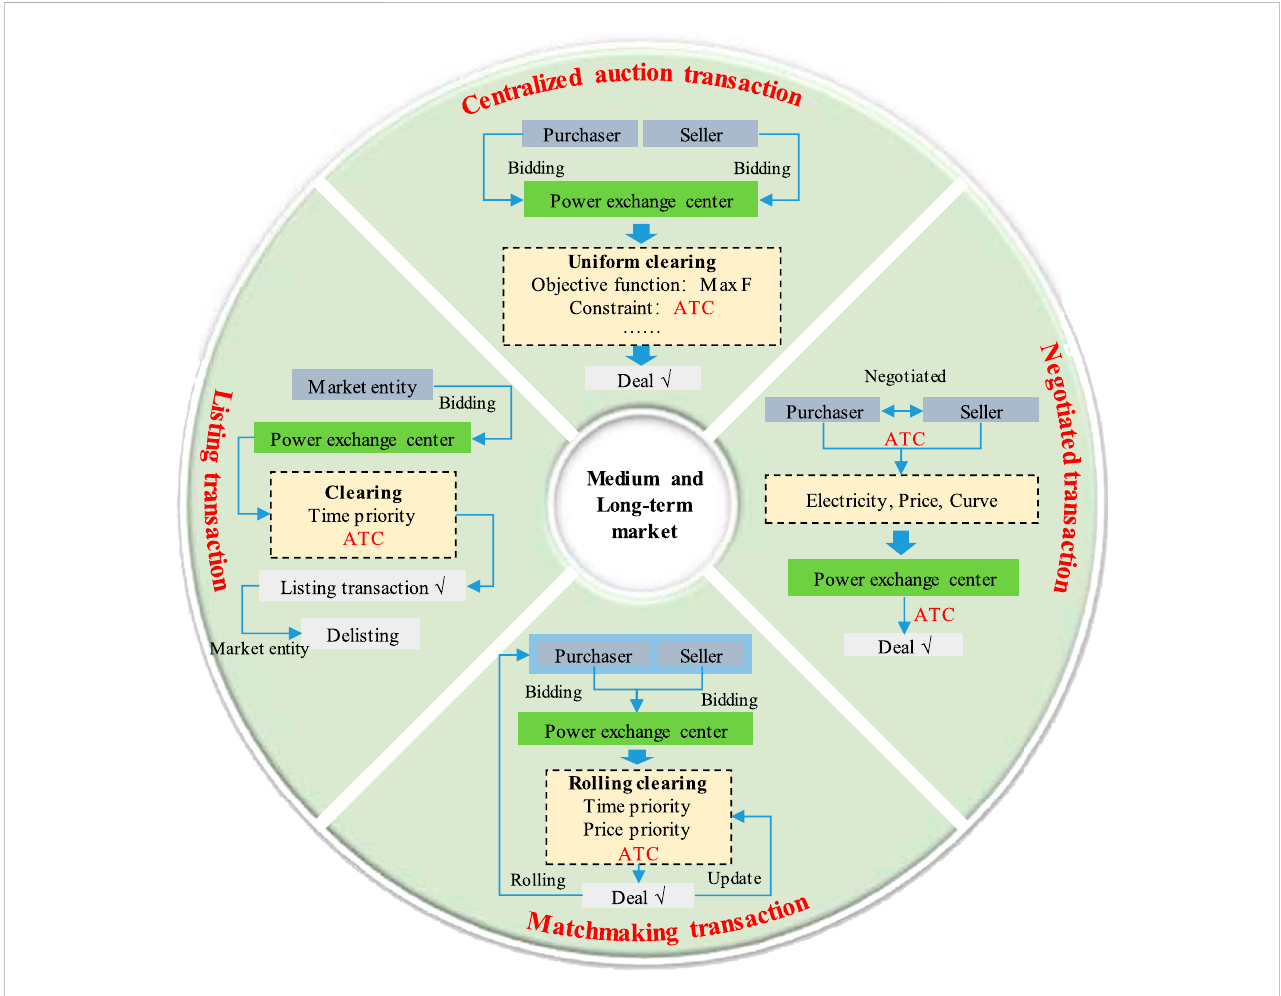
FIGURE 1 Intra-provincial M-L transaction mechanisms considering